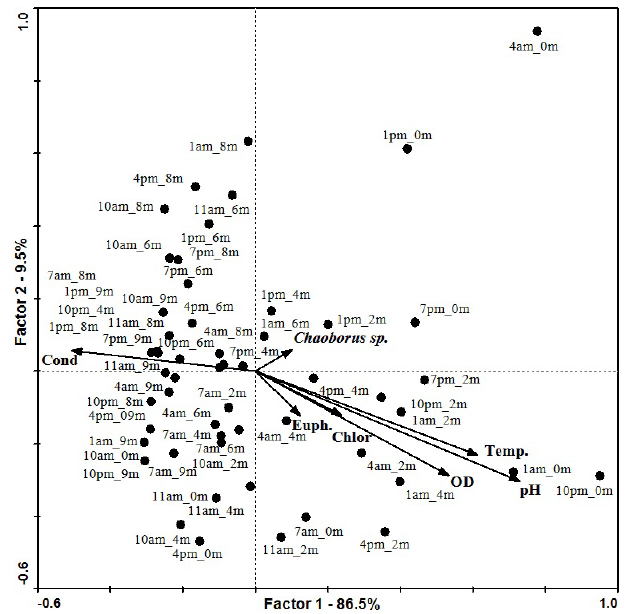
Figure 7. Principal Component Analysis (PCA) for every sample (time_depth) during a single nycthemeral cycle, at a study station in Furnas Reservoir, from 10 am of January 15 to 10 am of January 16, 2014. (Cond = electrical conductivity; Chlor = Chlorophyll a ; OD = dissolved oxygen concentration; Euph = euphotic zone; Temp =